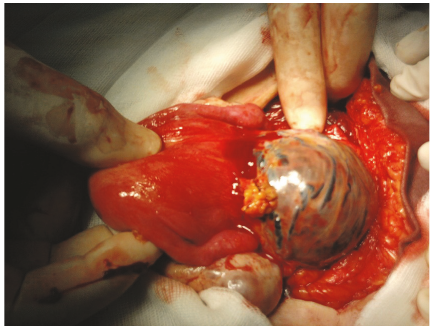
Figure 4: Operative view of anterior uterine